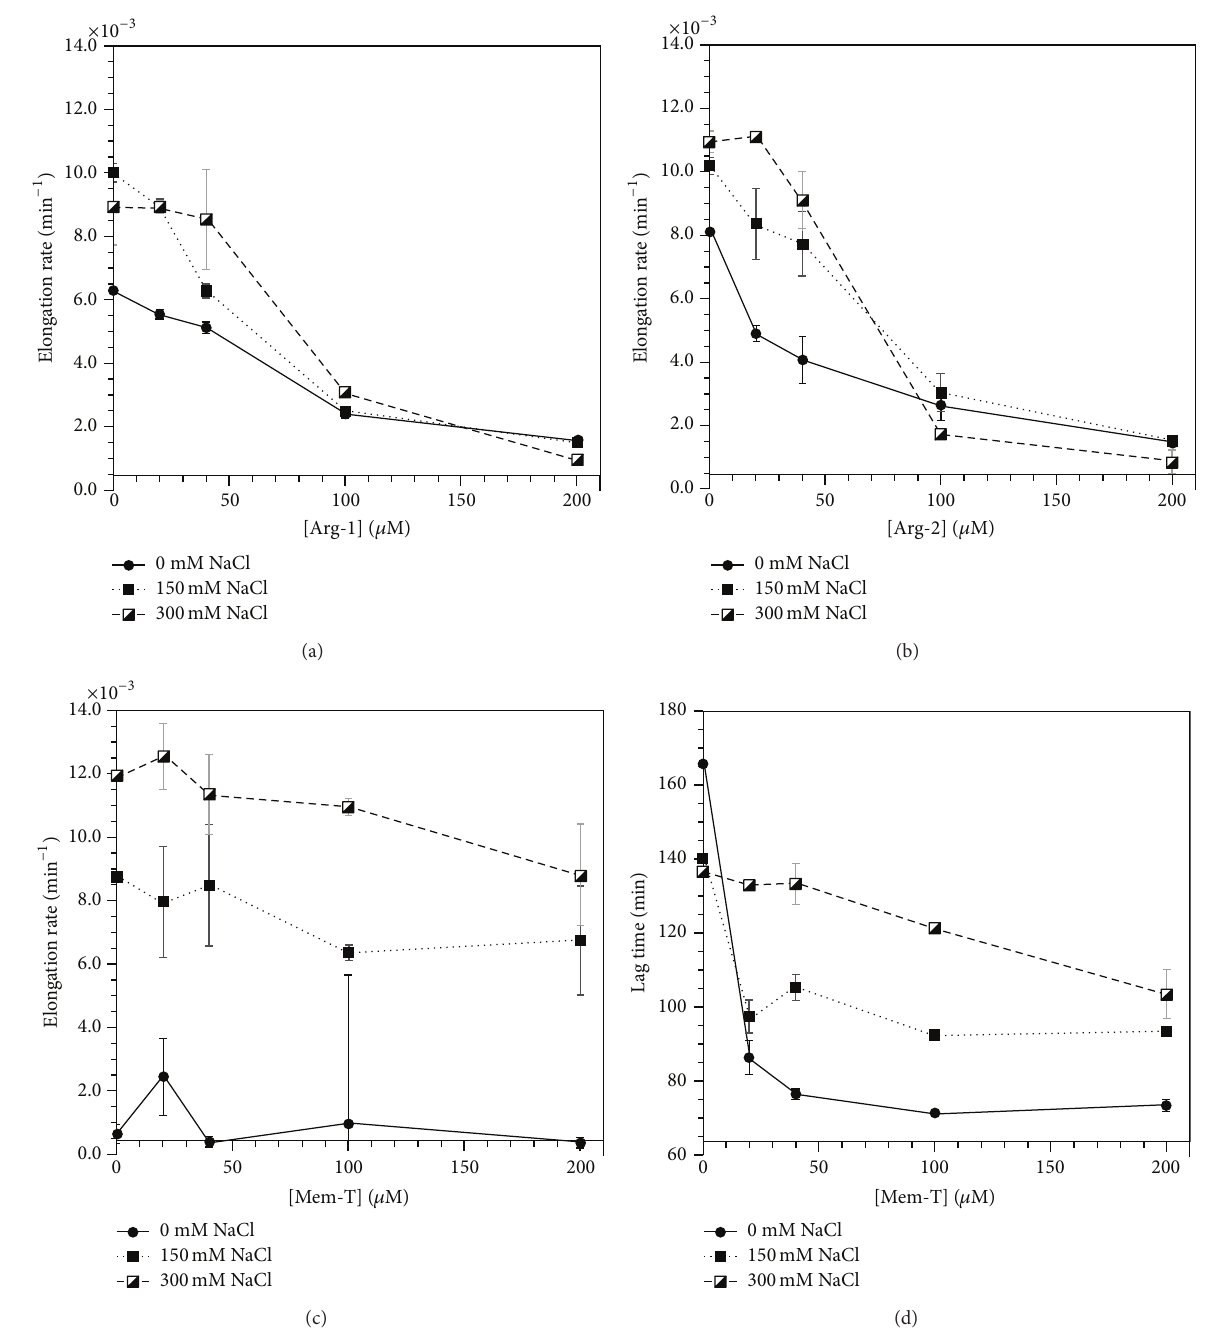
Figure 9: Salt-dependence on the effectiveness of charge-loaded analogs for the inhibition of 20 𝜇 M WT-amylin fibrillization. Fibril elongation rates with Arg-1 (a), Arg-2 (b), Mem-T (c), and lag times with Mem-T